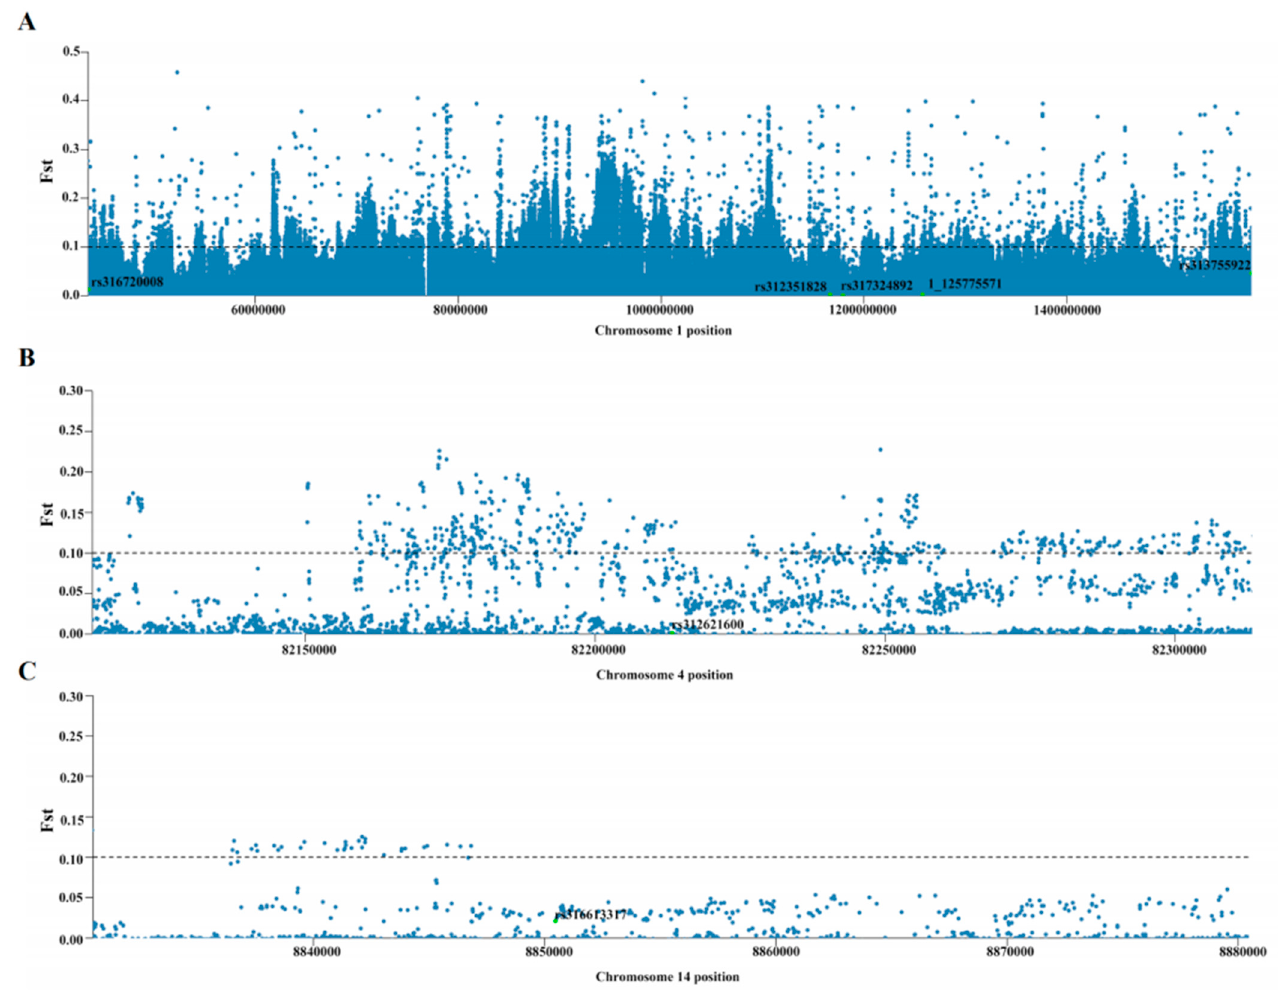
Figure 3. Locations of the candidate SNPs on chromosomes 1 and 14. ( A ) F ST of chromosome 1. ( B ) F ST of chromosome 4. ( C ) F ST of chromosome 14. Green represents significant SNPs located by genome-wide association study (GWAS), F ST threshold line: 0.1.